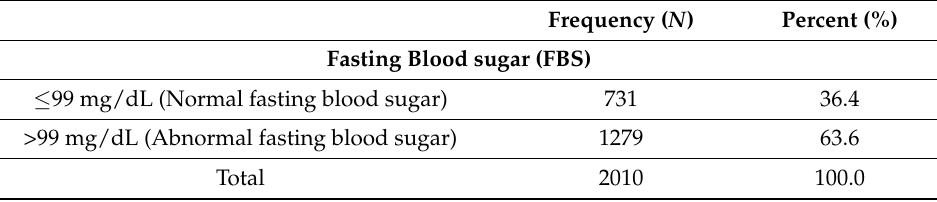
Table 6. Categorical distribution of biochemical